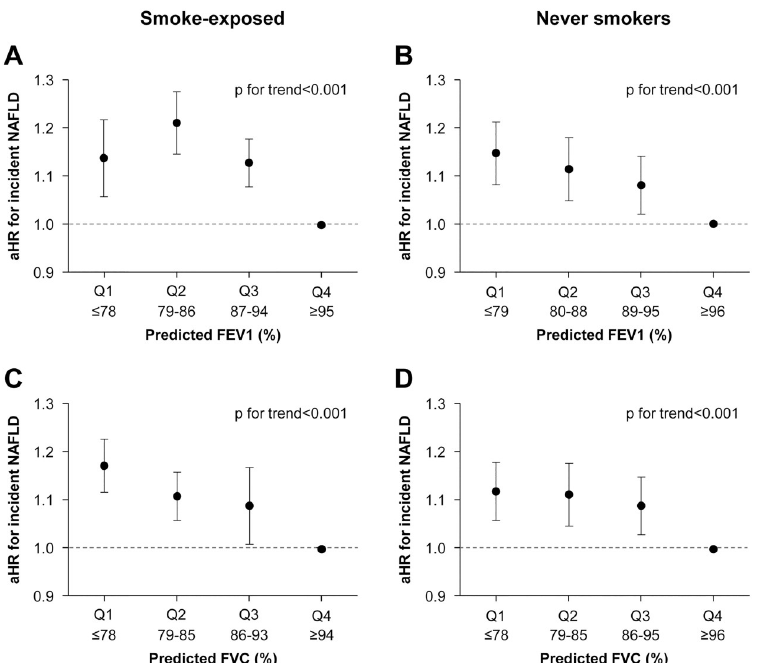
Fig 2. Multivariable-adjusted hazard ratios for incident nonalcoholic fatty liver disease according to quartile of lung function. Smoke-exposed subjects (A,C) and never smokers (B,D) were dived into quartiles according to baseline precentage of predcited values (% predicted) for FEV1 or FVC. Rregardless of smoking status, adjusted hazard ratios for incident NAFLD increased with decreasing quartiles of FEV1 (%) (A,B) and FVC (%) (C,D) in a dose-response manner ( p for trend < 0.001). The reference values was set at the highest quartile of FEV1(%) and FVC(%). Models was adjusted for potential covariates and metabolic laboratory markers including age, sex, BMI, alcohol intake, smoking, exercise, education level, center, year of test. aHR, adjusted hazard ratio; FEV1, forced expiratory volume in 1s; FVC, forced vital capacity; NAFLD, nonalcoholic fatty liver